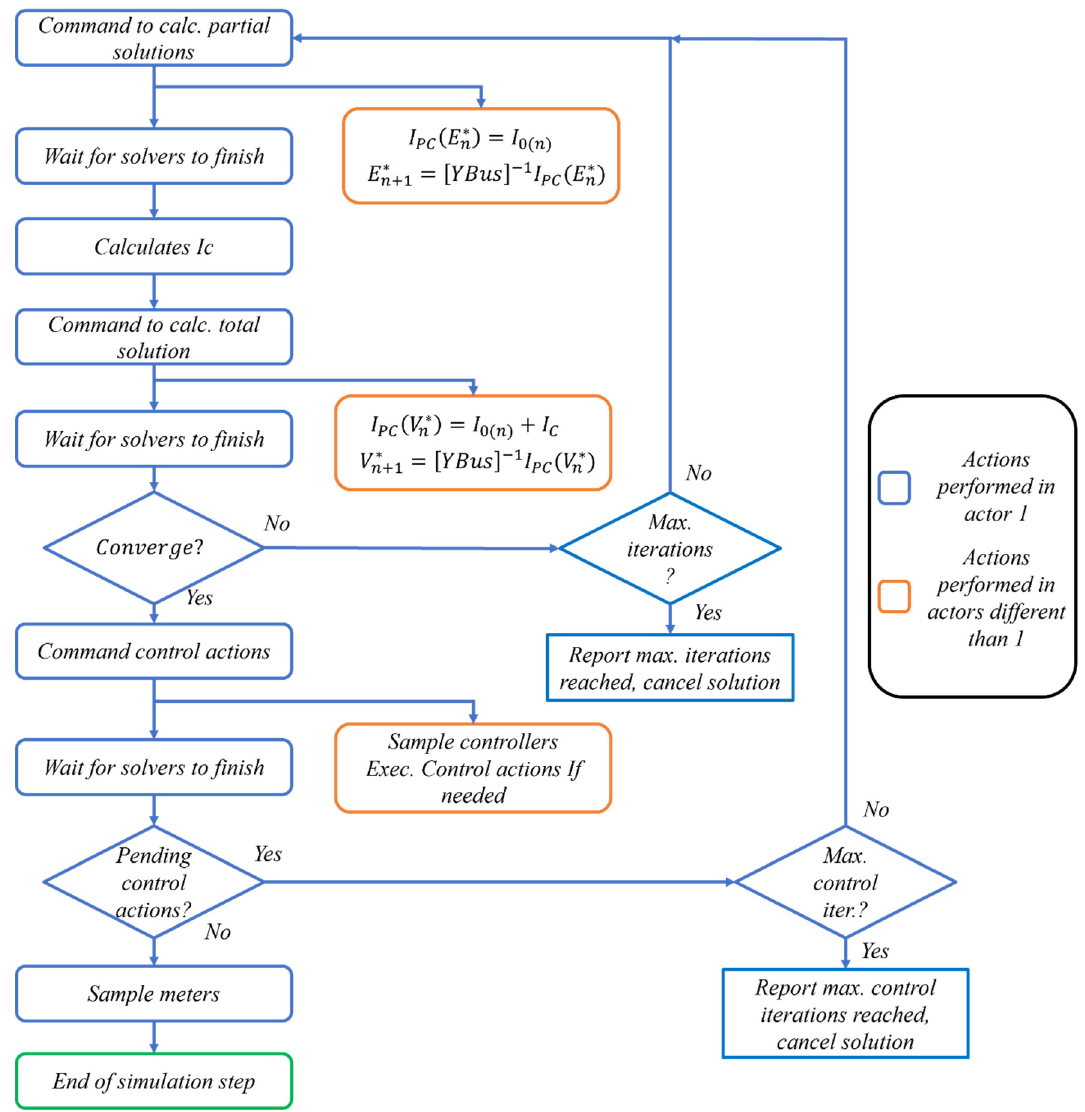
Figure 1. A-Diakoptics algorithm in OpenDSS.